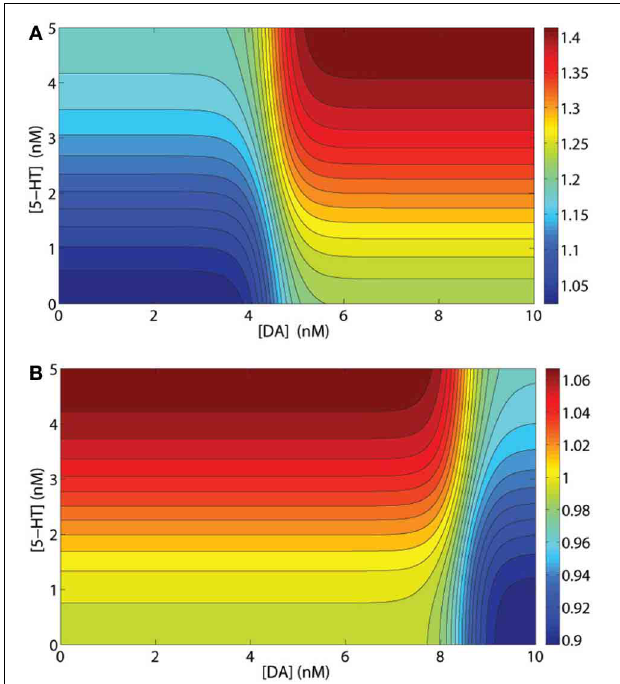
FIGURE 2 | Examples of synaptic current modulations. (A) Modulation factor of GABA mediated current from an inhibitory interneuron to a pyramidal cell, both expressing D1 and 5-HT2A receptors. (B) Modulation factor of an NMDA- or AMPA-mediated synaptic current by a presynaptic